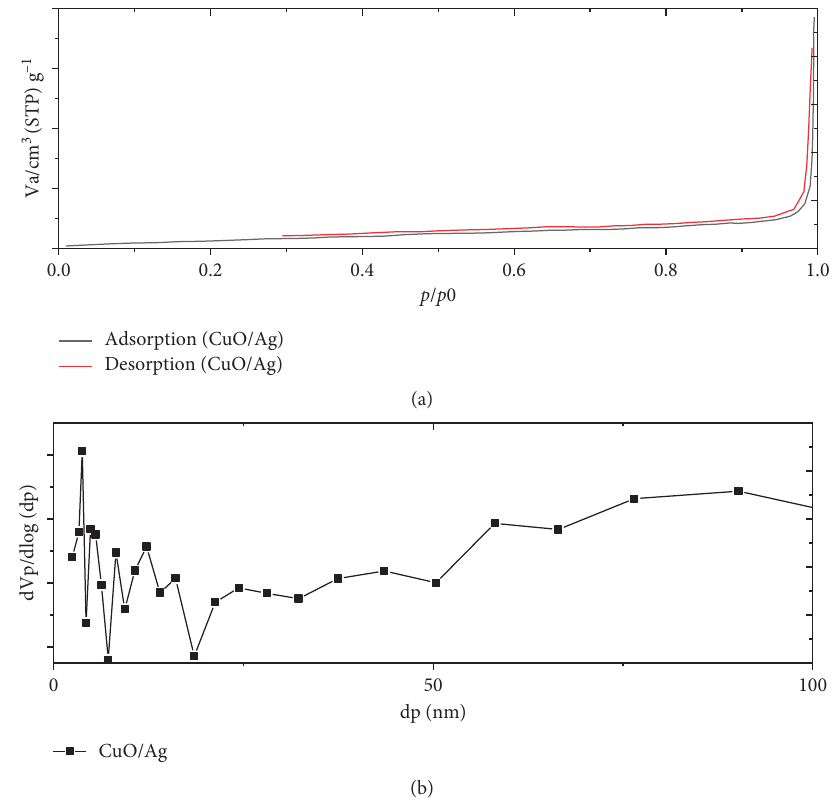
Figure 7: (a) Adsorption-desorption isotherms of nitrogen gas at 77K and associated (b) BJH plot showing the pore size distribution of